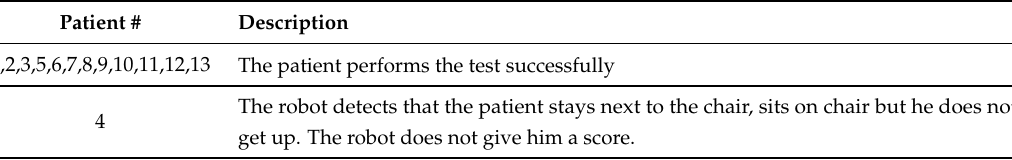
Table 11. Get Up & Go tests